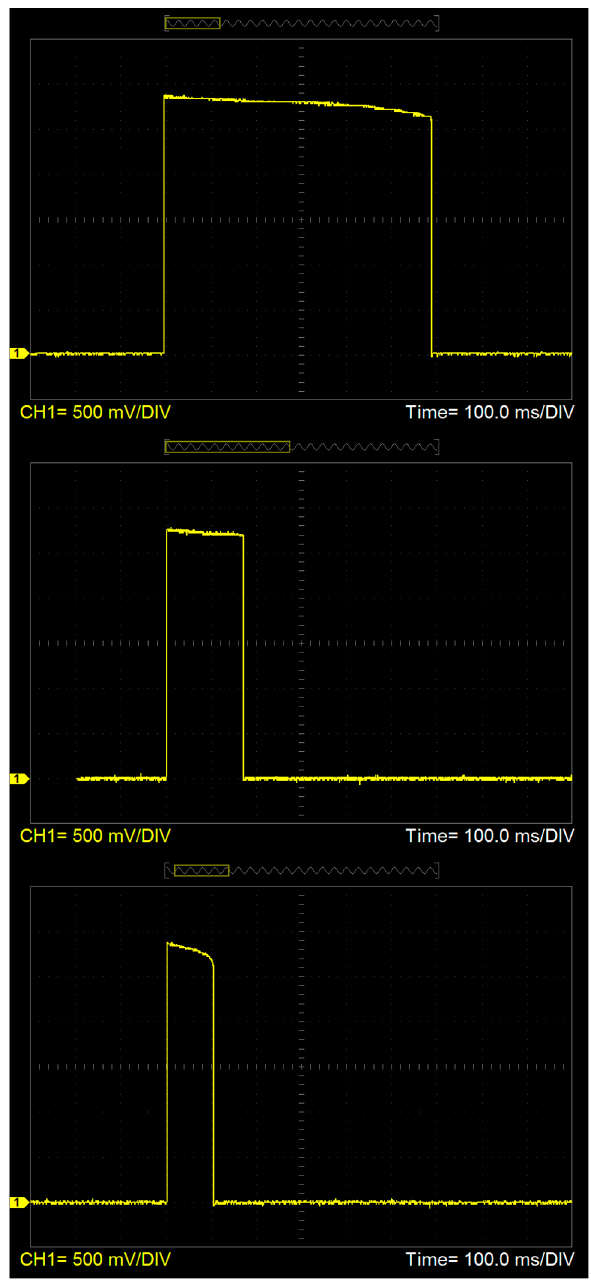
Figure 4. Comparison of the voltage waveforms representing the breaking times in the tested fuse- links with a rated current of 0.5 (A) and an overcurrent of 1.5 (A) (from the top fuses distributed by